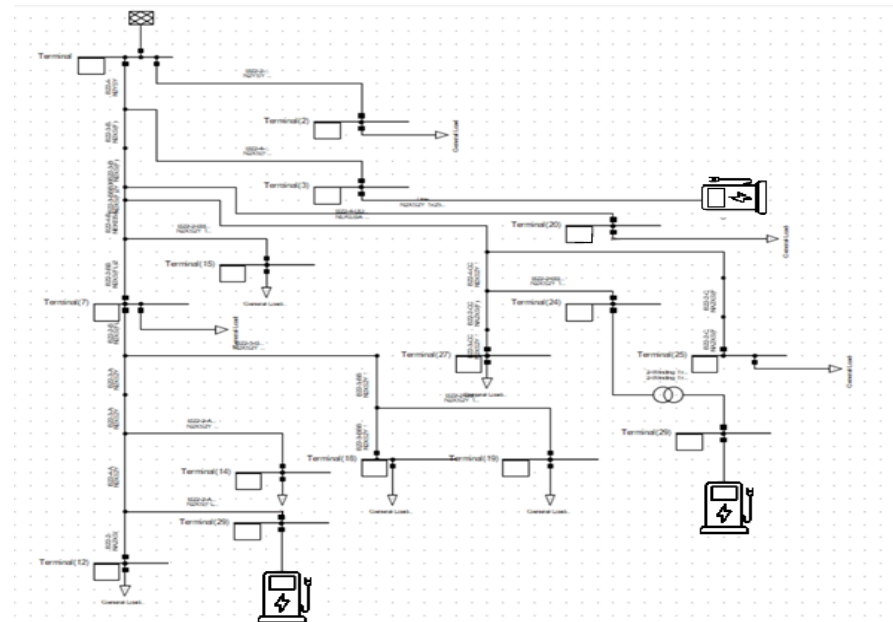
Figure 17. Commercial 20 kV distribution network.